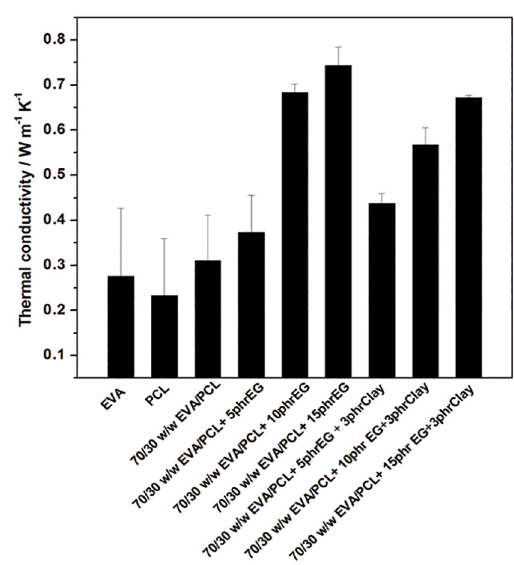
Figure 10: Thermal conductivities of EVA/PCL blend and different blend composites